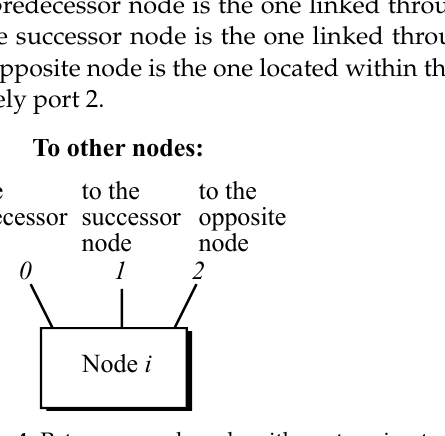
Figure 4. Petersen graph node with ports going to their neighboring